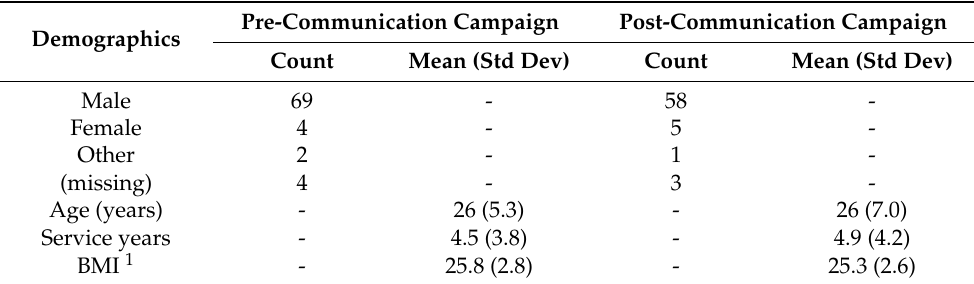
Table 2. Demographics for survey participants: pre- and post-communication (pre n = 79; post n = 67 surveys).